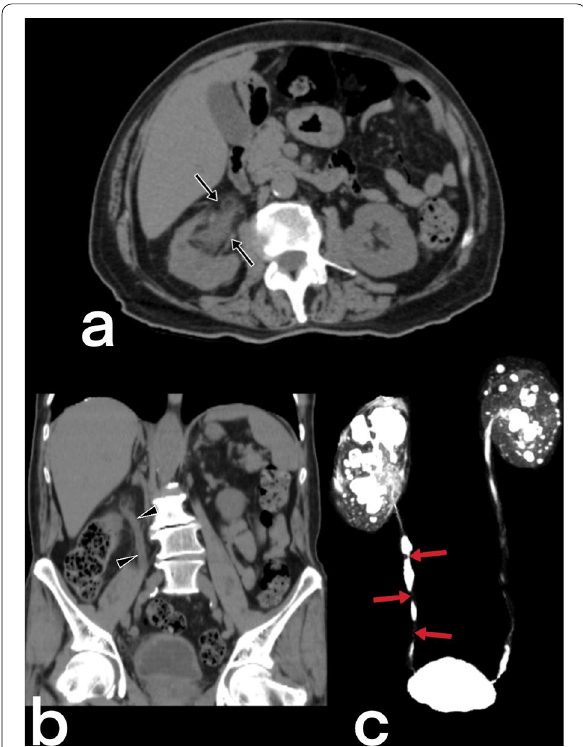
Fig. 37 Axial ( a ) and coronal ( b ) non-contrast CT scan of a 74-year-old male with urinary tuberculous reveal debris collection within the dilated right renal pelvis and dilated right ureter with diffuse wall thickening. 3D MIP Coronal T2-weighted MR urogram shows strictures (arrows) of the right ureter